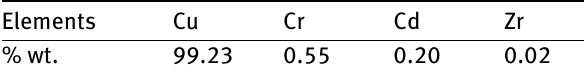
Figure 1: Test scheme for determining the strength of adhesive bonds on the slice and the molecular component of the coeflcient of friction: 1—spherical indenter; 2 & 3—test